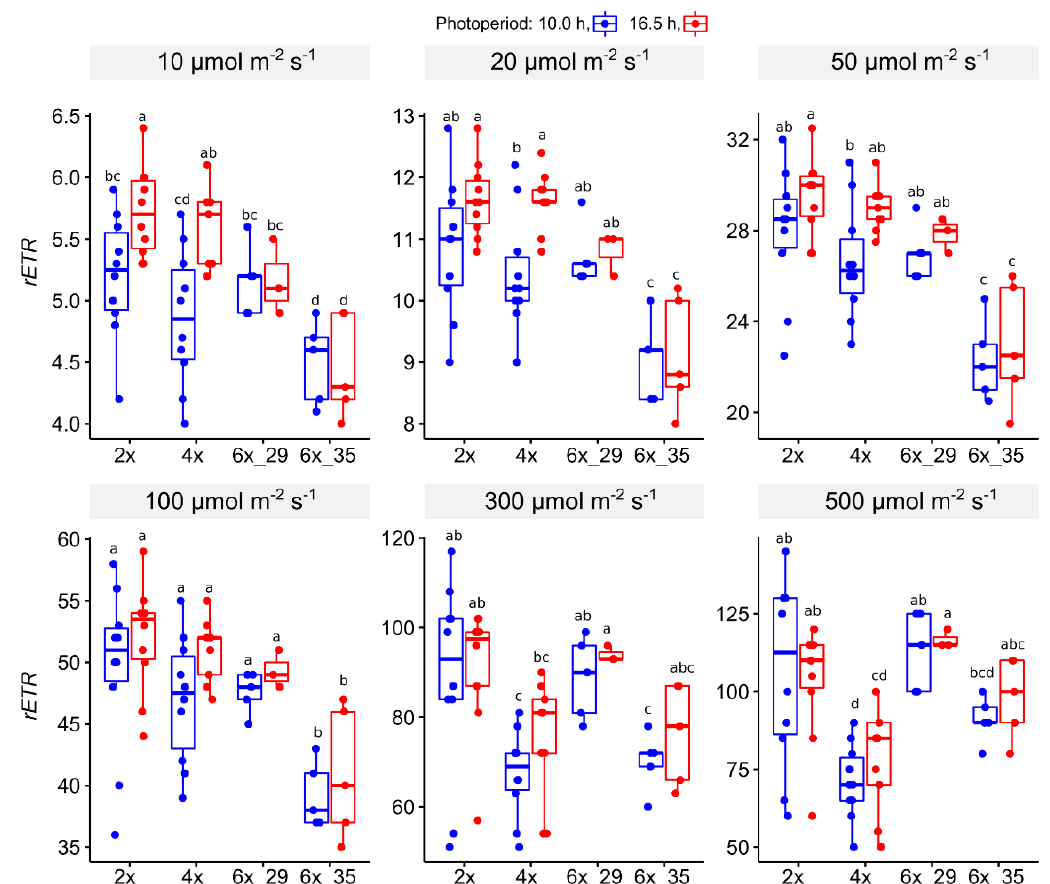
Figure 4. Relative electron transport rate (rETR) from light curve (LC) experiments of R. auricomus cytotypes exposed to two different photoperiods in increasing actinic light PPFD; for summary statistics, see Table S5, letters represent 95% Duncan. Boxplots show the 25th, median, and 75th percentile range, and jitter plots represent the exact data distribution.